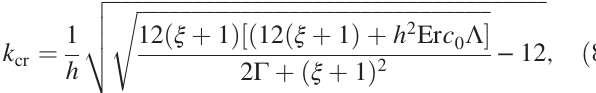
FIG. 7. Linear stability analysis of the aligned state. (a) Density plot of the growth rate Re ½ σ ð k Þ(cid:3) vs k x , k y for ξ growth rate occurs along the nematic direction ( x axis). (b) Re ½ σ ð k Þ(cid:3) vs k x , k y ¼ 0 , for different ξ ¼ 2 π =k wavelength L vs c , from Eq. (8). The dashed line is the fit L cr cr